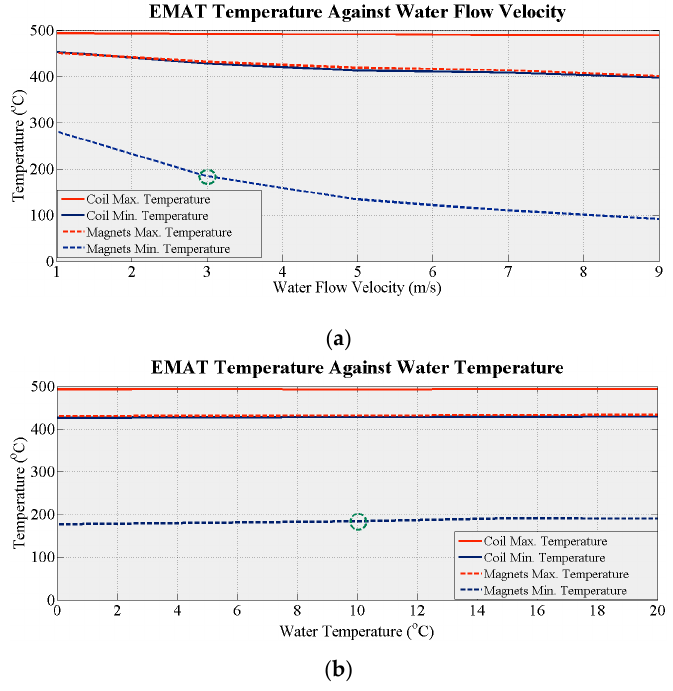
Figure 5. ( a ) EMAT temperature against coolant flow velocity; ( b ) EMAT temperature against coolant temperature.